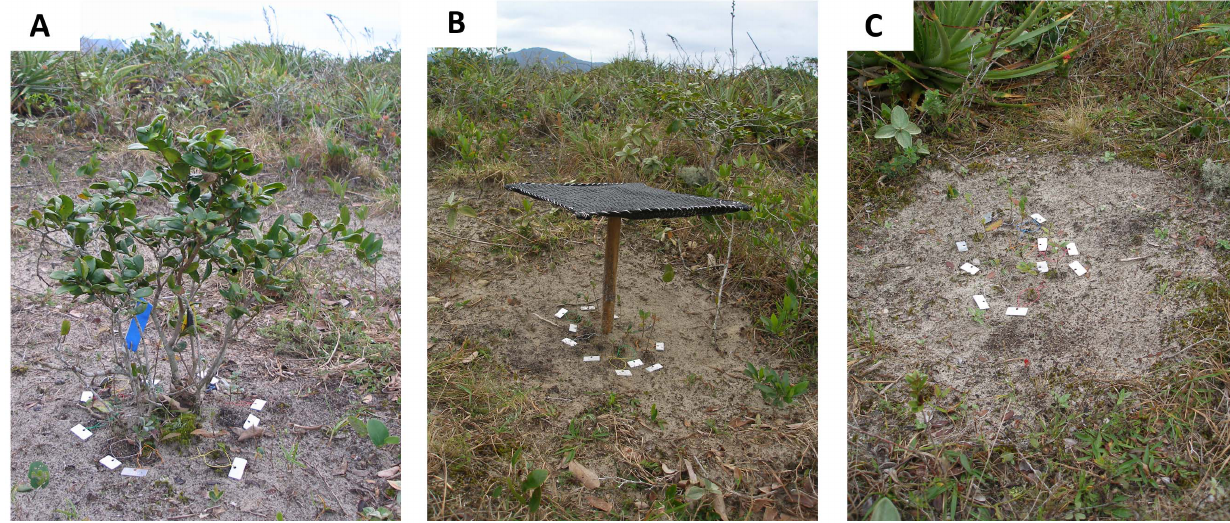
Figure 1. Three levels of the neighbor factor implemented to investigate if shading is the mechanism that causes adults of Guapira opposita to provide a nurse effect on survival of Ternstroemiabrasiliensis seedlings in coastal dune vegetation in Sa˜o Paulo, Brazil. A) beneath a G. opposita canopy; B) beneath artificial shade provided by a mimic of G. opposita shade; and C) control with no neighbor and no shade. In the three levels of neighbor, it is possible to see the seedlings of Ternstroemia brasiliensis with their metallic tags. All other plants in a 0.5 m radius were regularly clipped.